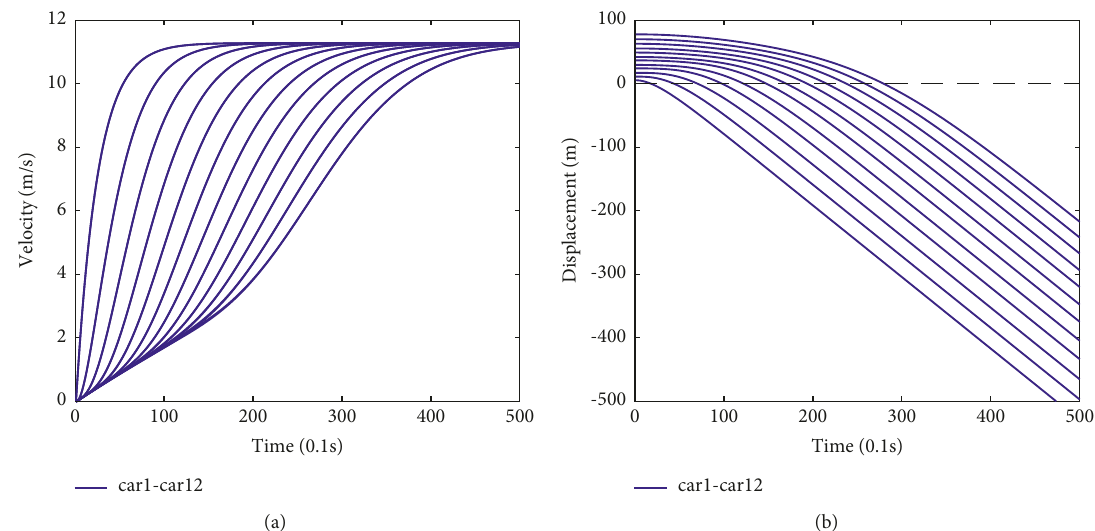
Figure 16: The numerical simulation diagram in 0% heavy vehicles scenario. (a) Velocity simulation diagram. (b) Displacement simulation diagram.